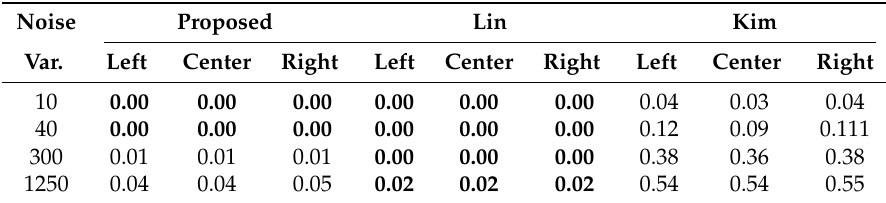
Figure 13. Average BER for signal distorted right images. ( a ) additive Gaussian noise; ( b ) JPEG compression. Table 7. Average BER for Gaussian noise